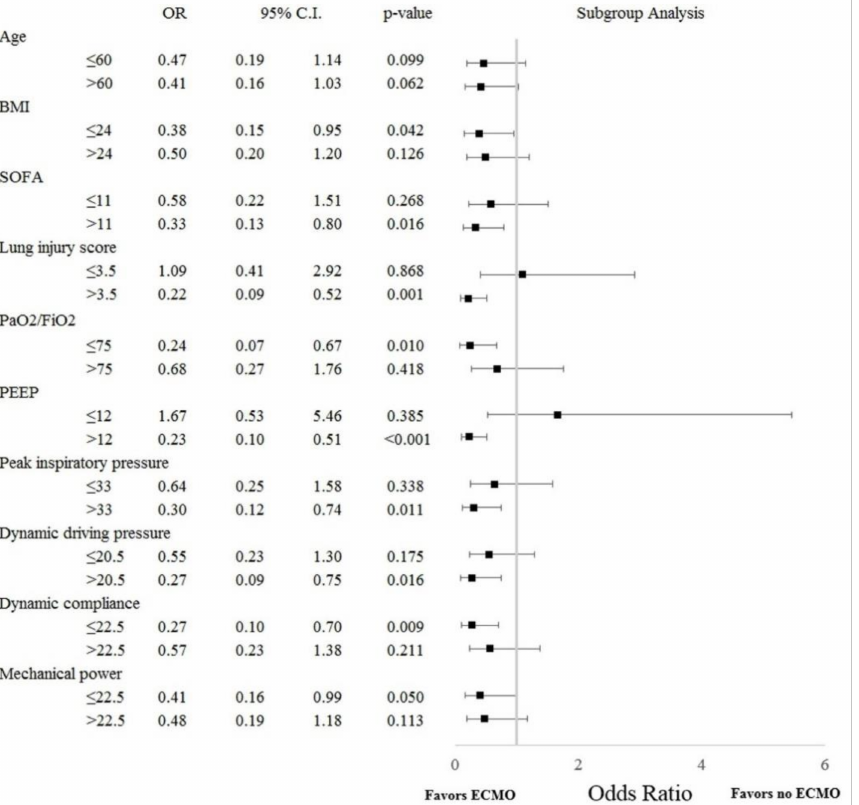
Figure 3. Subgroup analysis of hospital mortality as a function of baseline clinical variables. (BMI, body mass index; CI, confidence interval; ECMO, extracorporeal membrane oxygenation; FiO 2 , fraction of inspired oxygen; OR, odds ratio; PaO 2 , partial pressure of oxygen in arterial blood; PEEP, positive end-expiratory pressure; SOFA, sequential organ failure